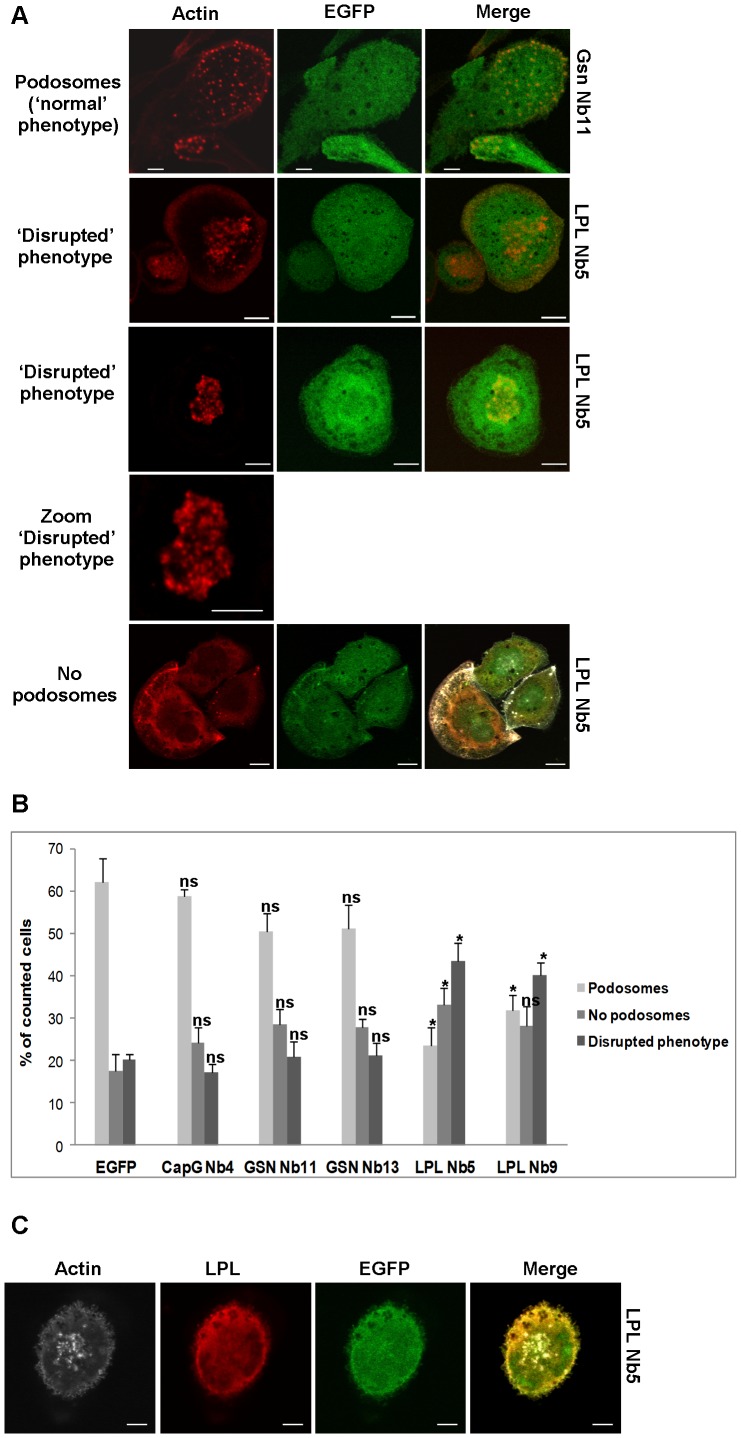
LPL Nbs disturb podosome integrity.(A) Confocal images showing the different phenotypes, observed in THP-1 macrophages. Cells expressing GSN Nb11 or LPL Nb5 are shown in green and cells were stained for F-actin (phalloidin-alexa 594, red). Bar: 10 µm. (B) Representation of the observed phenotypes (‘Podosomes’, ‘No podosomes’ and ‘Disrupted phenotype’) for the different constructs. 600–1200 cells were counted per condition in 4–5 independent experiments. Error bars represent mean ± SEM. Unpaired t-tests were performed to observe statistical differences between cells expressing EGFP and cells expressing the nanobodies (ns: non significant p>0.05; * p<0.05). (C) THP-1 macrophages stably expressing LPL nanobodies show a diffuse LPL staining. Cells were stained for F-actin (phalloidin 670, far red, shown in grey) and L-plastin (alexa-594, red). LPL Nb5 is shown in green. Pictures were acquired with a confocal laser scanning microscope and are representative for four independent experiments. Bar: 10 µm.